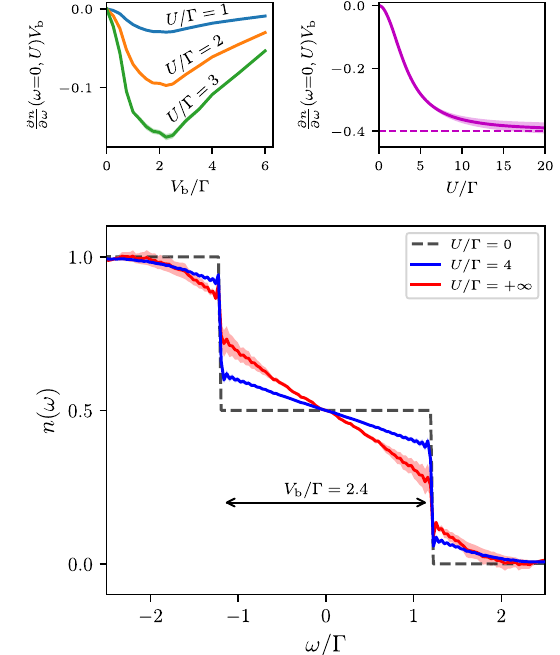
FIG. 17. Bottom: Out-of-equilibrium electron distribution func- 2 . 4 Γ . = Γ ¼ 0 ) under a bias voltage V tion on the impurity ( ϵ d b ¼ The distribution function is defined as in Eq. (20). Increasing the interaction strength ( U= Γ ¼ 4 blue line, U= Γ ¼ þ ∞ red line) leads to a softening of the characteristic double step of the noninteracting distribution function (dashed line). It is linear between the Fermi levels of the two leads. The Euler transform is used for resummation, and the result is not submitted to Bayesian inference. Top: Normalized slope of the distribution function near ω ¼ 0 as a function of the bias voltage (left) and interaction strength (right). For an intermediate interaction, the normalized 2 Γ (left). At a strong slope reaches an extremum near V b ¼ 2 . 4 Γ interaction, the normalized slope saturates (right, for V b ¼